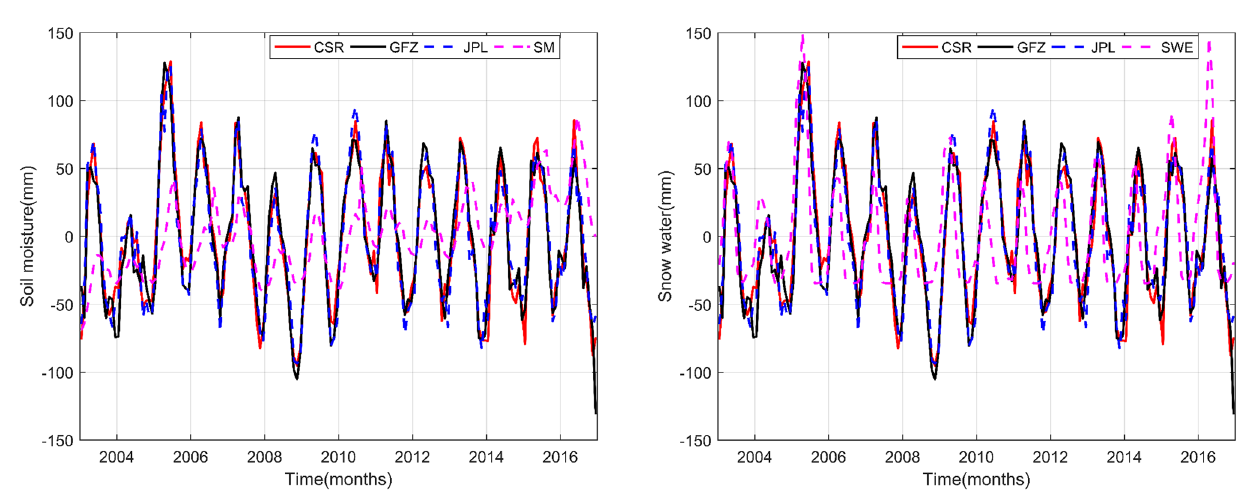
Table 3 Correlation between soil moisture and snow water with CSR, GFZ, and JPL computed using Spearman’s rho method